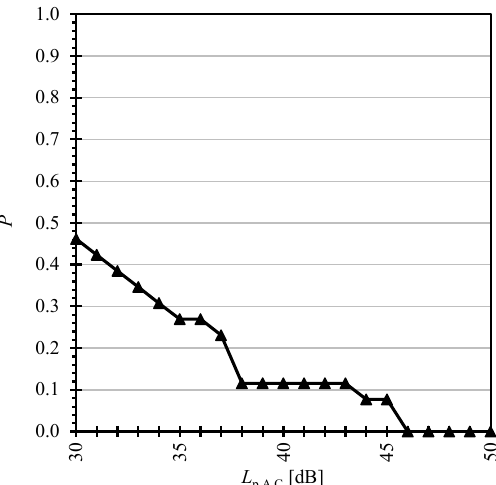
Figure 5. The probability P among the 26 offices of Ref. [17] that the comfort distance, defined by comfort criterion level L p,A,C , was larger than the room length.